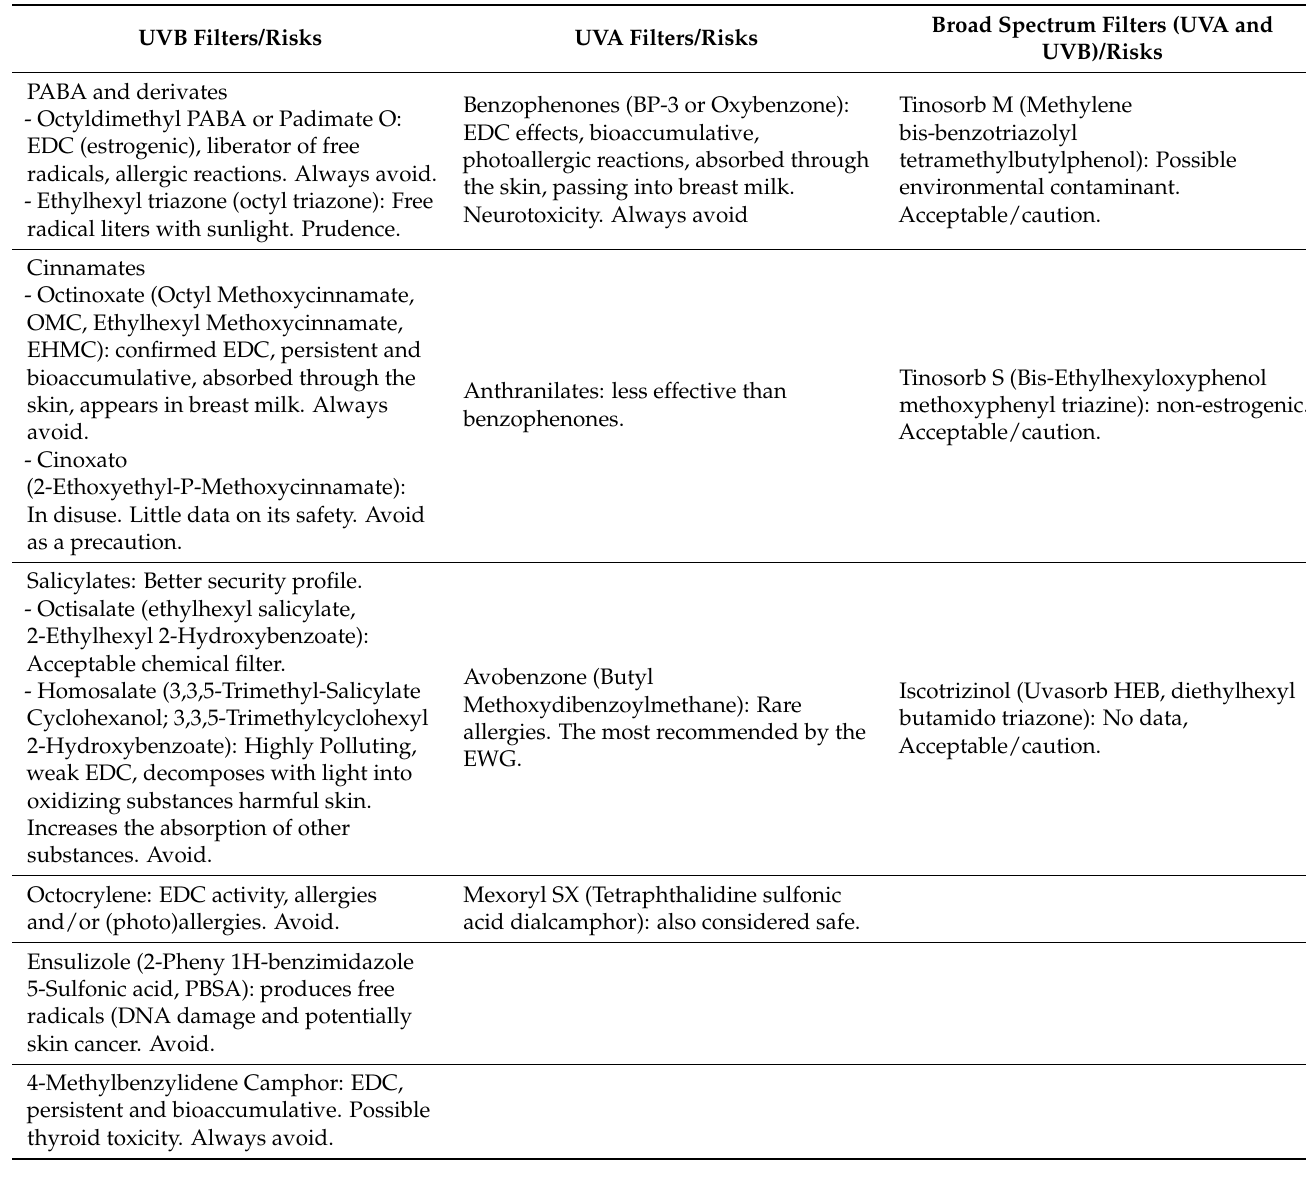
Table 1. The most used organic filters and their possible risks (based on EWG